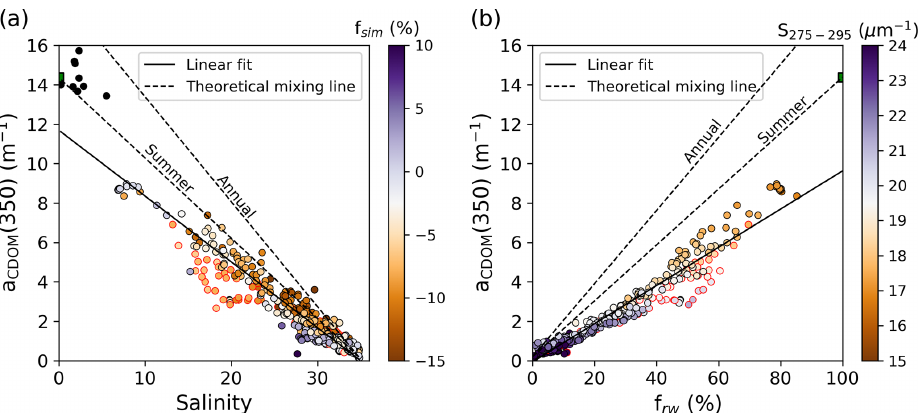
Figure 4. (a) Salinity, a CDOM (350) and the percentage of sea-ice meltwater fraction ( f sim %) measured in the LS in summer (NE10, LD10, YS11, VB13, VB14, AT18 and TA19_4) and (b) percentage of river water ( f rw %), a CDOM (350) and S 275 − 295 . The solid black line represents the linear regression fit to the data in the LS. The dashed black lines show the theoretical conservative mixing line between Lena River water after spring freshet (Summer, a CDOM (350) of 14.4m − 1 calculated from Juhls et al., 2020) and the marine endmember (Nansen Basin, NB, seawater), as well as the theoretical conservative mixing line of year-round flow-weighted average CDOM absorption of the Lena River (Annual, a CDOM (350) of 18.7m − 1 based on year-round measurements in the Lena Delta, April 2018–April 2019; Juhls et al., 2020) and the marine endmember. Red outlined dots are water samples from the surface layer ( < 20m) taken north and east of the Lena Delta in September 2011. Black dots in (a) represent samples on which stable oxygen isotope analysis was not performed (LD10).